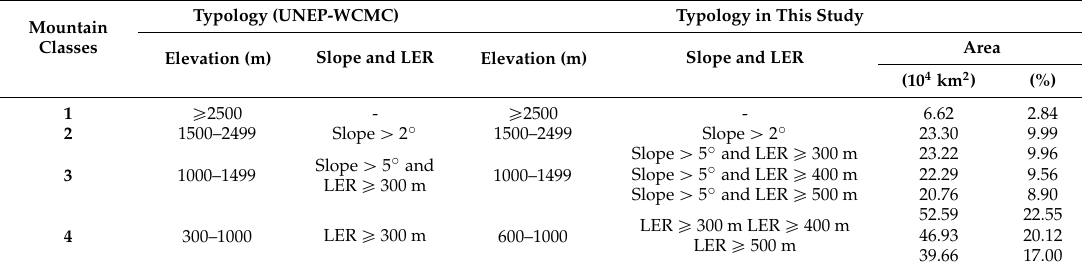
Table 1. Mountain classification definition based on two typology systems in MSEA * (30-m DEM).